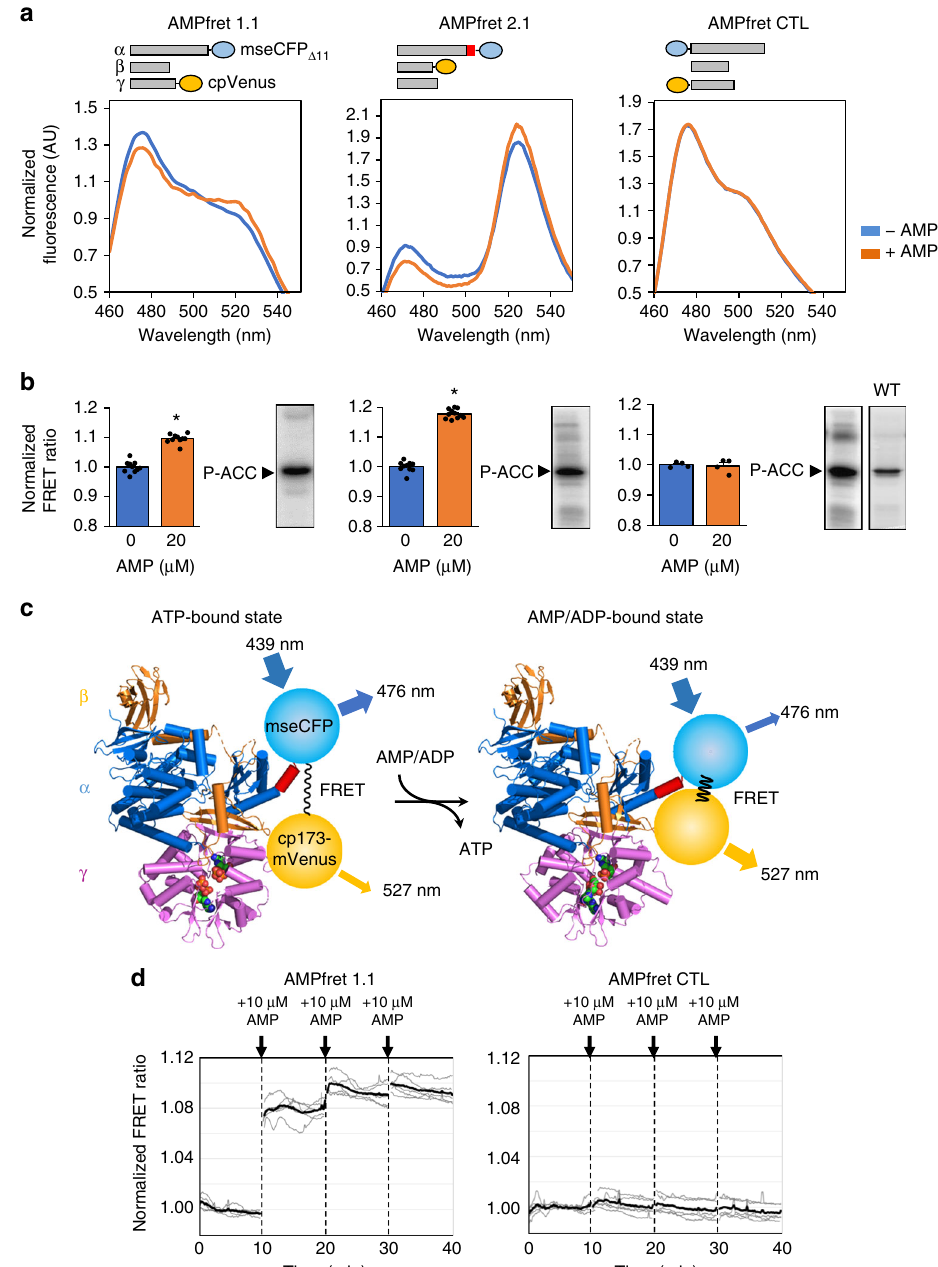
Fig. 1 FRET changes in response to AMP. a AMP-dependent variation of fl uorescence emission spectra of AMPfret constructs 1.1 and 2.1 and AMPfret- negative control (CTL) (blue line: no AMP, orange line: 20 µ M AMP). Spectra normalized to the isosbestic point at 512 nm. AMPfret topologies are depicted on top (bars: AMPK subunits, red box: putatively rigid helix, blue circles: cyan fl uorescent protein mseCFP Δ 11 , yellow circles: yellow fl uorescent protein cp173-mVenus). b Normalized FRET ratio of AMPfret constructs calculated from a (same color code), and corresponding autoradiograms of in